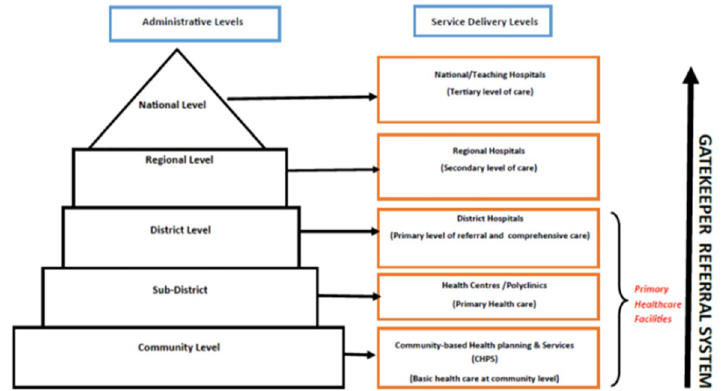
Fig 1. The health care system structure in Ghana [Source: Authors’